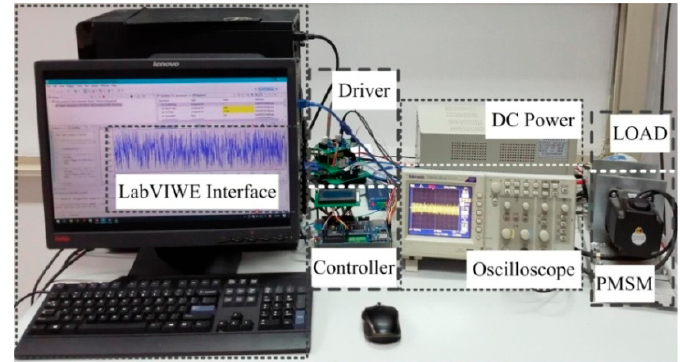
Figure 13. Experimental setup of control system.